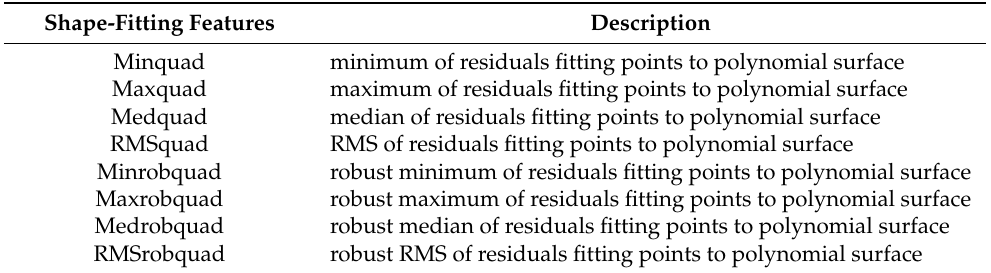
Table 4. Overview of the shape-fitting